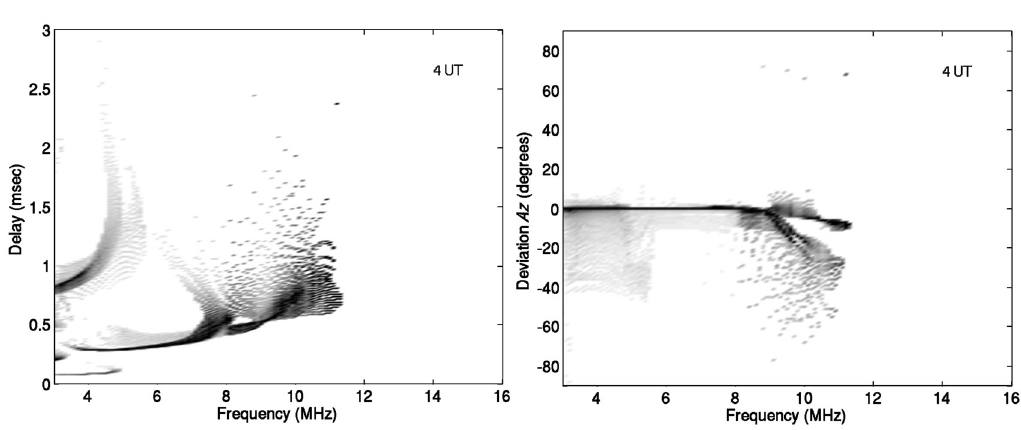
Fig. 14.8. Oblique ionogram produced by ray tracing simulations through an ionosphere containing patches of enhanced electron